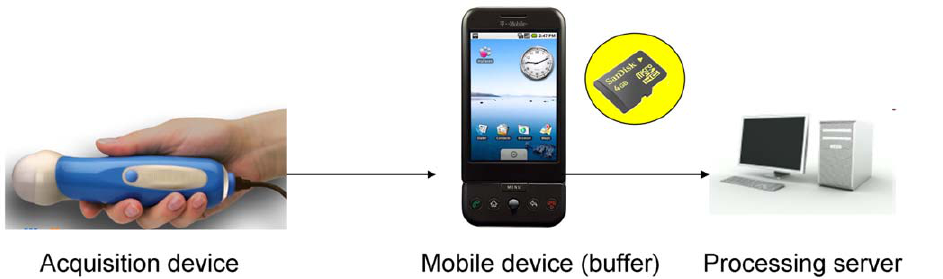
Figure 2. Data Storage Mechanism. The raw data flowing from the mobile device which acts as a storage device. Once a connection is available, the data is being transferred to the server for processing.